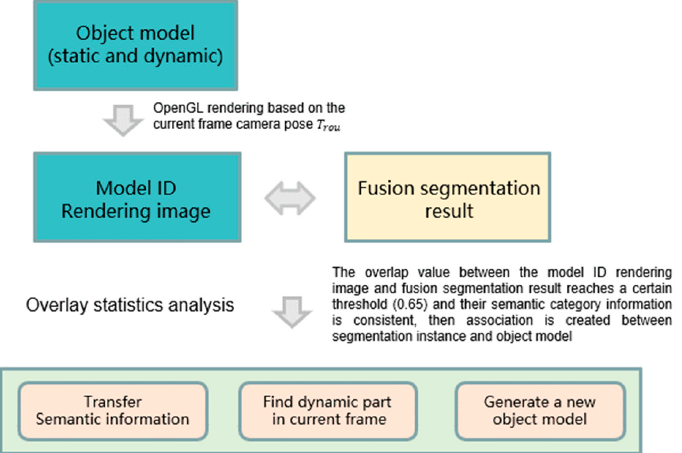
Figure 5. Segmentation results are associated with the object model database to find the dynamic part in the current frame, create a new object, and transfer the semantic information.